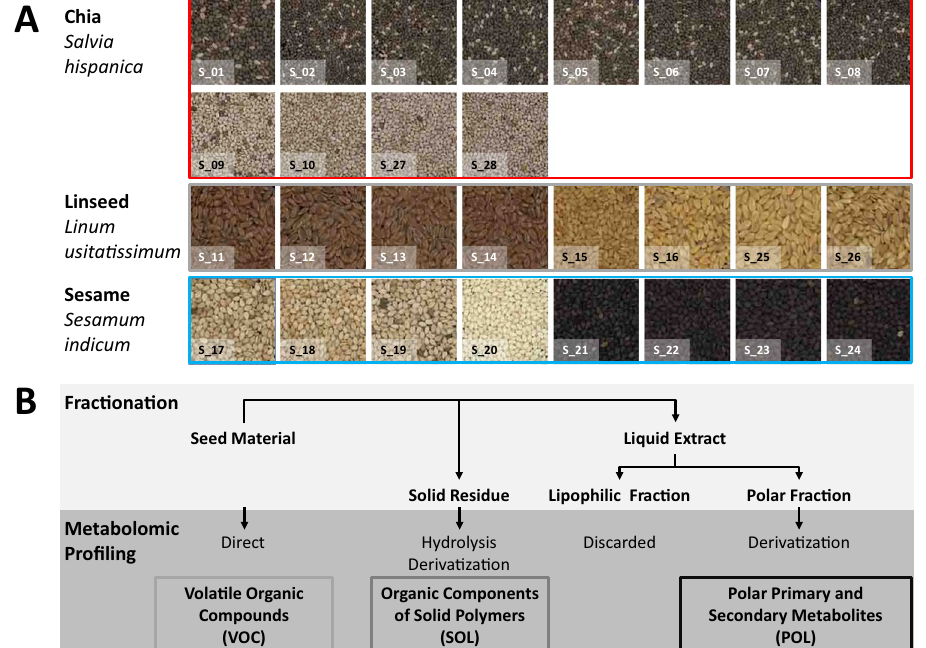
Figure 1. Reference samples and chemical profiling scheme for the discovery of differential metabolic markers of chia, linseed and sesame seeds. ( A ) Reference seed batches (S_01 - S_28) that were marketed for human consumption were collected from local grocery stores (Berlin, Germany) with anonymized vendor information (Table S1). Note that two colour variants of each seed type were included. All seed batches except S_20 contained the seed coat. The colour code, chia (red), linseed (grey) and sesame (blue) is used throughout the study. ( B ) Chemical fractionation and chemical profiling scheme of reference seed material. Rapid direct profiling of volatile organic compounds (VOC) was performed by headspace solid phase micro-extraction gas chromatography – mass spectrometry (SPME-GC-MS). A solid fraction (SOL) was obtained after exhaustive extraction of soluble metabolites. Solids were hydrolyzed and components analyzed by chemical derivatization and GC-MS. A polar liquid extract (POL) that was enriched for primary and small specialized metabolites was analyzed by chemical derivatization and routine GC-MS profiling. Note that the lipophilic liquid extract was omitted, because seed processing for human consumption frequently involves seed defatting and/or addition of fats from other